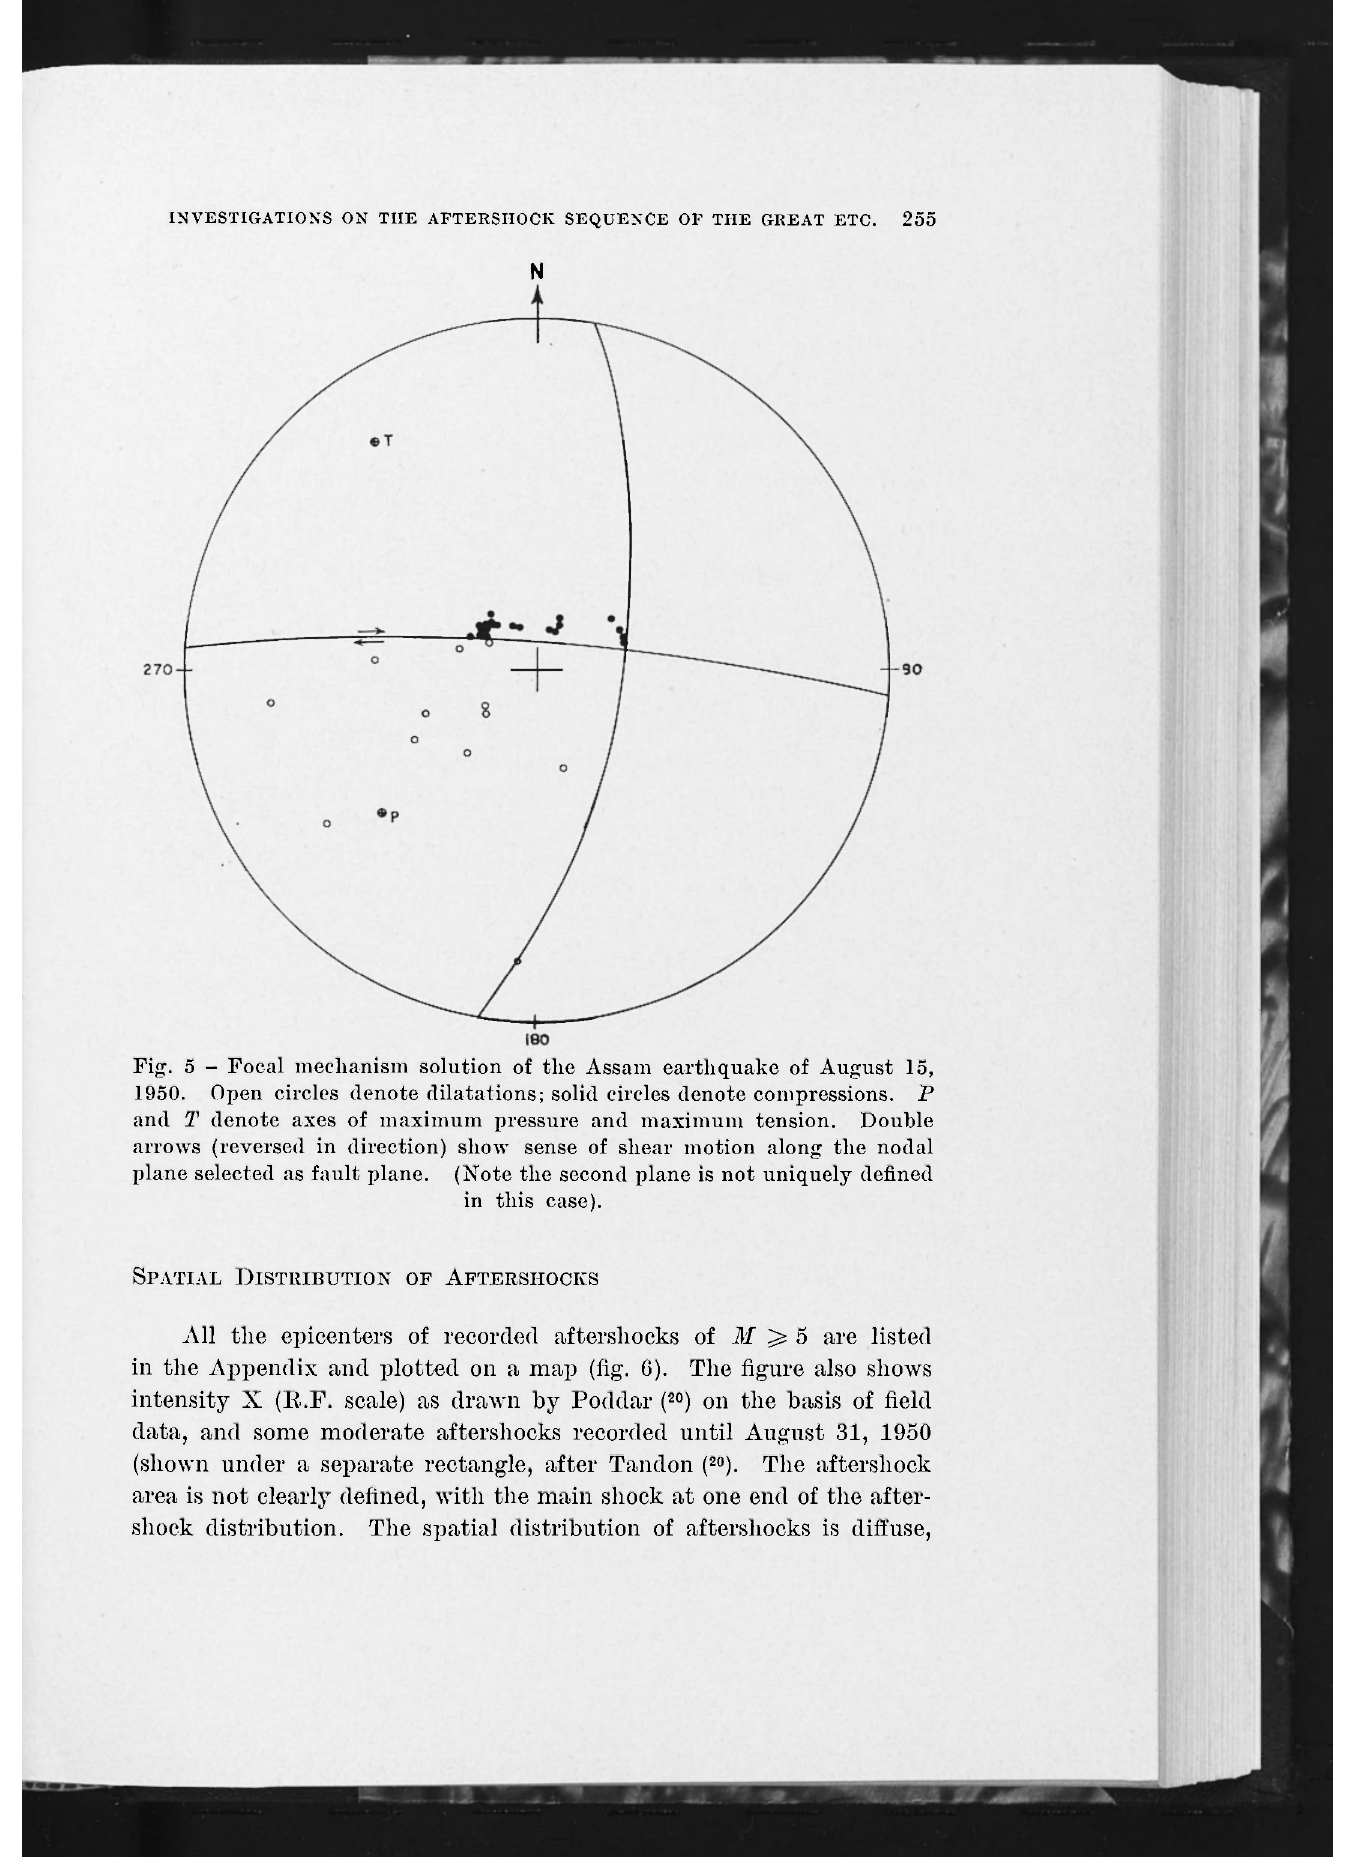
Fig. 5 - Focal mechanism solution of the Assam earthquake of August 15, 1950. Open circles denote dilatations; solid circles denote compressions. P and T denote axes of maximum pressure and maximum tension. Double arrows (reversed in direction) show sense of shear motion along the nodal plane selected as fault